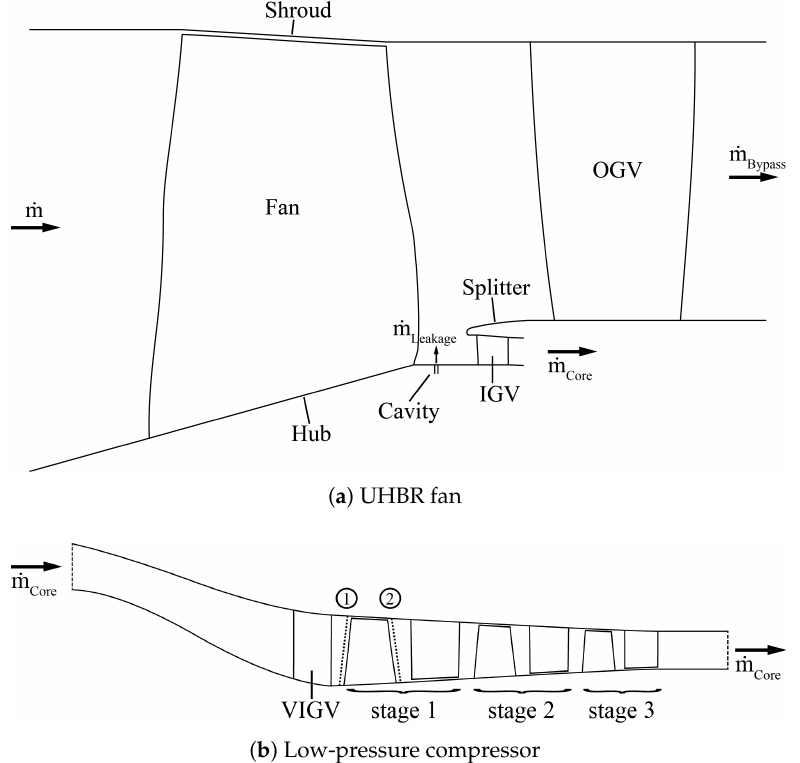
Figure 1. Reference configurations in the meridional